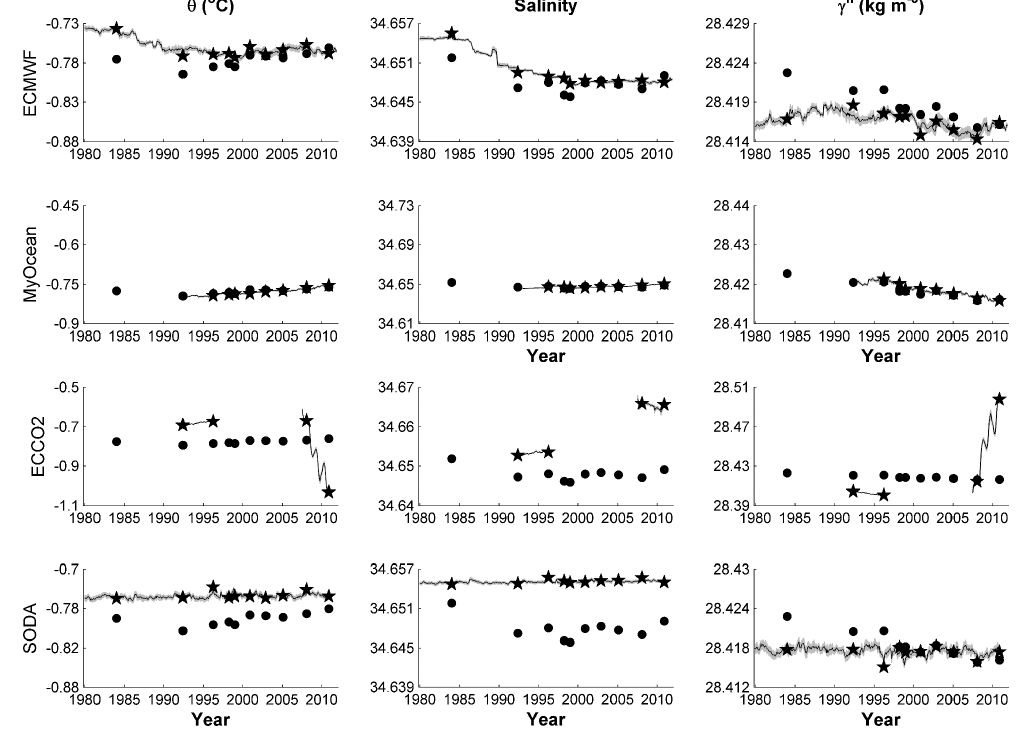
Figure 15. Same as in Fig. 11, but for WSBW. 1154